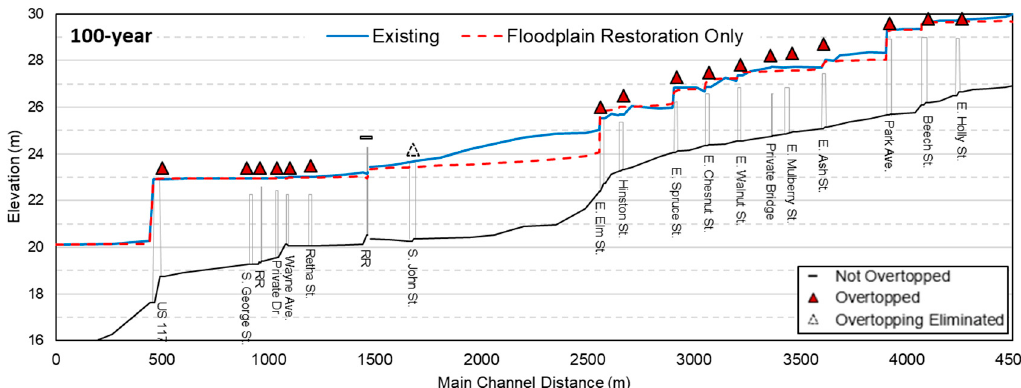
Figure 7. Water surface profiles for the Existing Condition and the Restoration Only scenario for the 100-year event.